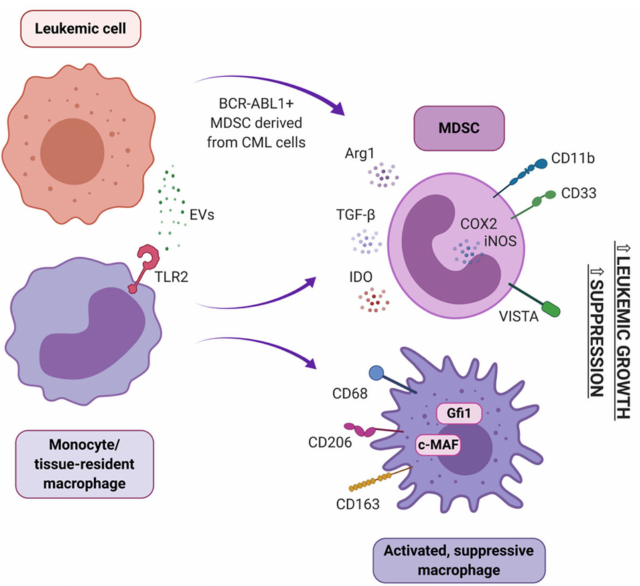
Figure 5. Origin and activity of highly suppressive MDSC and macrophages in myeloid leukemia – immune cells that suppress effector immune response, as well as directly support leukemic cell growth. Monocytes and tissue-resident macrophages can polarize towards either suppressive macrophages or myeloid derived suppressor cells (MDSC), e.g. due to influence of leukemic EVs. MDSC can also differentiate from BCR-ABL1+ chronic myeloid leukemia cells. Suppressive macrophages and MDSC express variety of factors (either soluble or receptors, indicated on each type of cell) that hamper effector cells function and support leukemic growth. EVs–extracellular